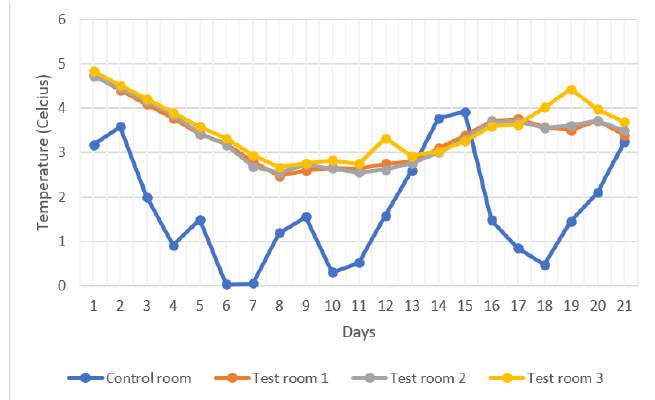
Figure 6. Comparison of temperature data of control room and test rooms.